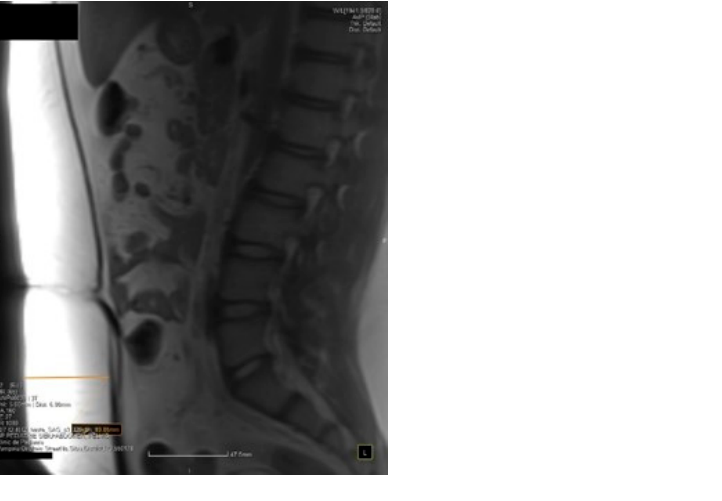
Figure 5. MRI T2 HASTE, sagittal section tangent to T5 showing the measurement of abdominal